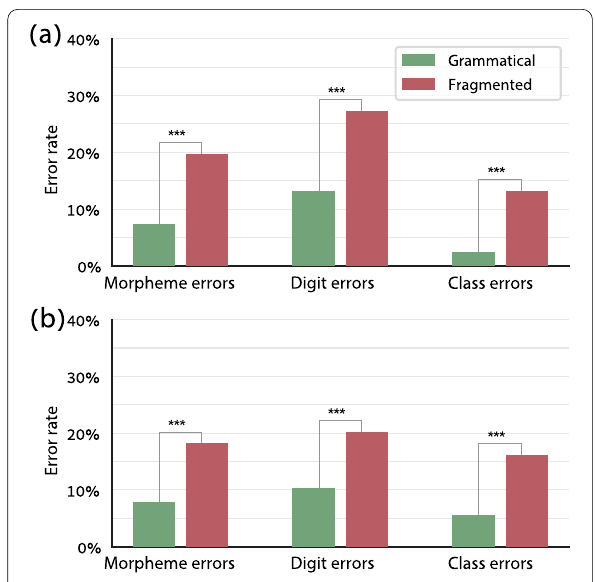
Fig. 6 Results of Experiments 3 ( a ) and 4 ( b ). The morpheme error rate, digit error rate, and class error rate were lower in the grammatical conditions than in the fragmented ones. Asterisks denote the significance of the Condition factor in the linear mixed model described in the text (all p <